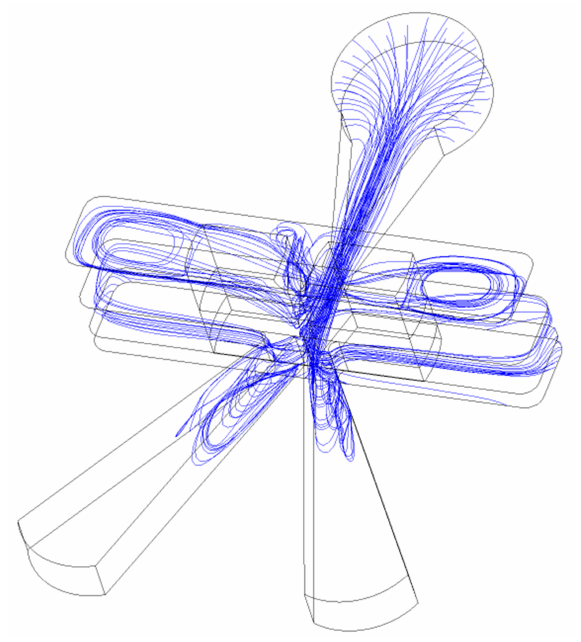
Figure 7. Particle trajectories.